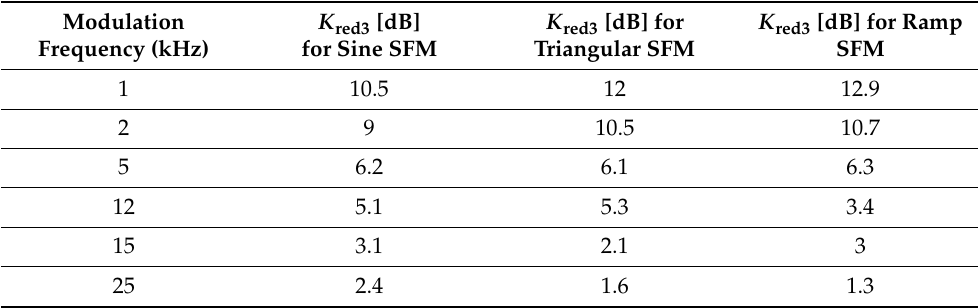
Table 3. Radiated emission reduction coefficients and the efficiency of the WPT system under the measurements with three-switching-frequency technique used. Note: when f m = 2 or 5 kHz, then RBW was chosen to be 1 kHz; when f m = 0.5 or 0.35 kHz, then RBW = 0.1 kHz. Scheme Type K red1 (dB)